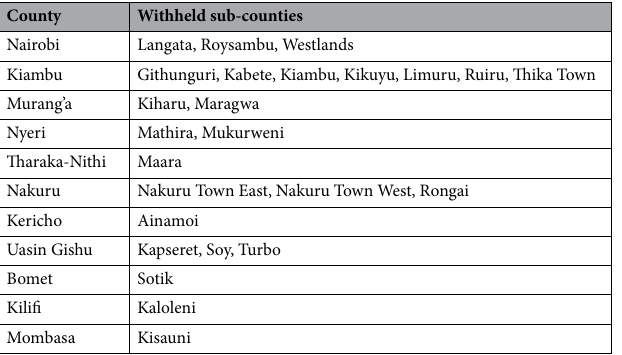
Table 6. High burden sub-counties from each of 11 counties held out in turn from model fitting during geographically based cross-validation.